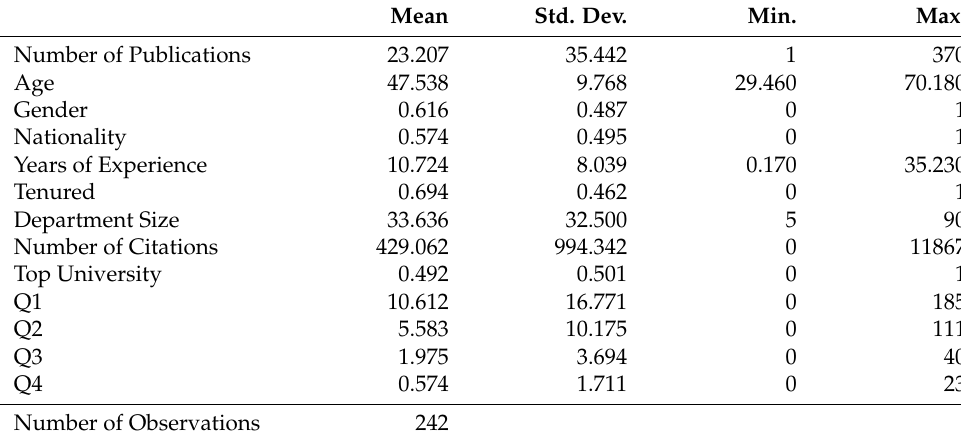
Table 1. Summary